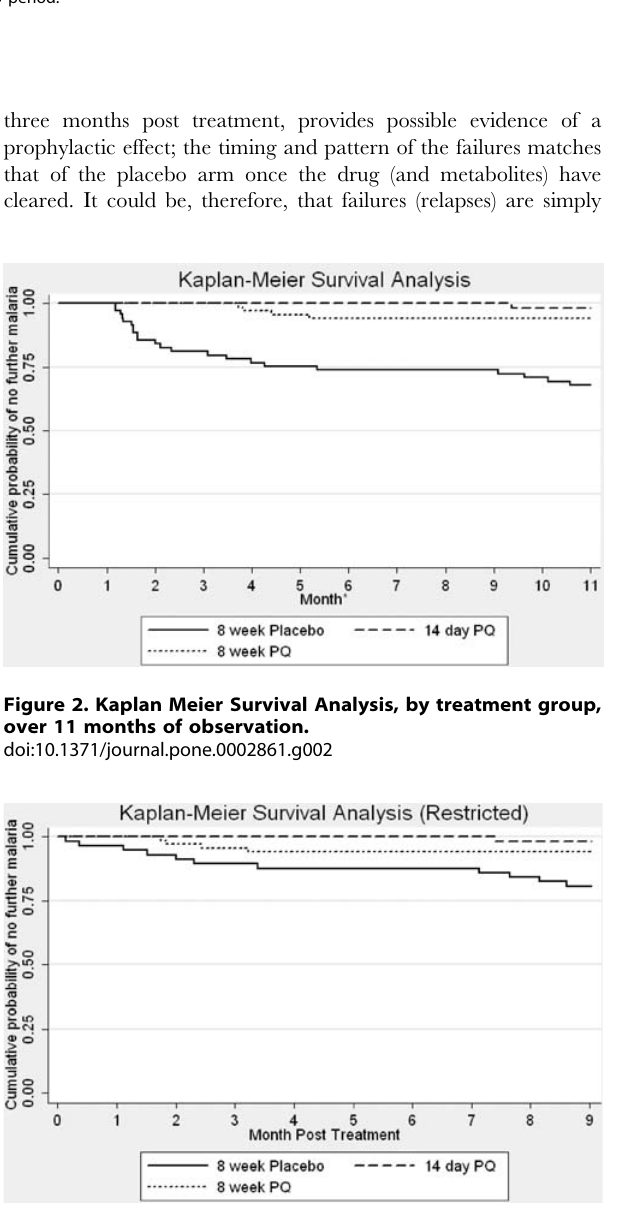
Figure 3. Kaplan Meier survival analysis, by treatment group, restricted to post-treatment period (months 2–11).